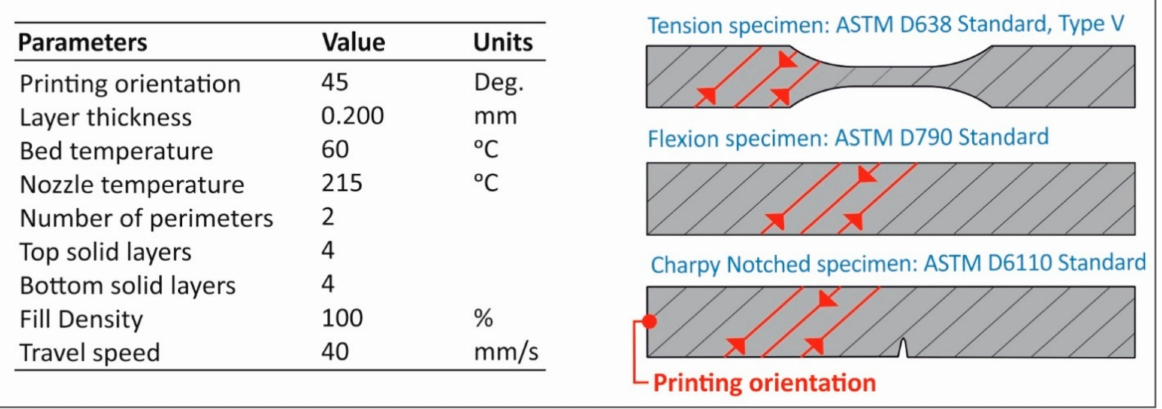
Figure 2. 3D Printer’s fundamental parameters set up to slicer